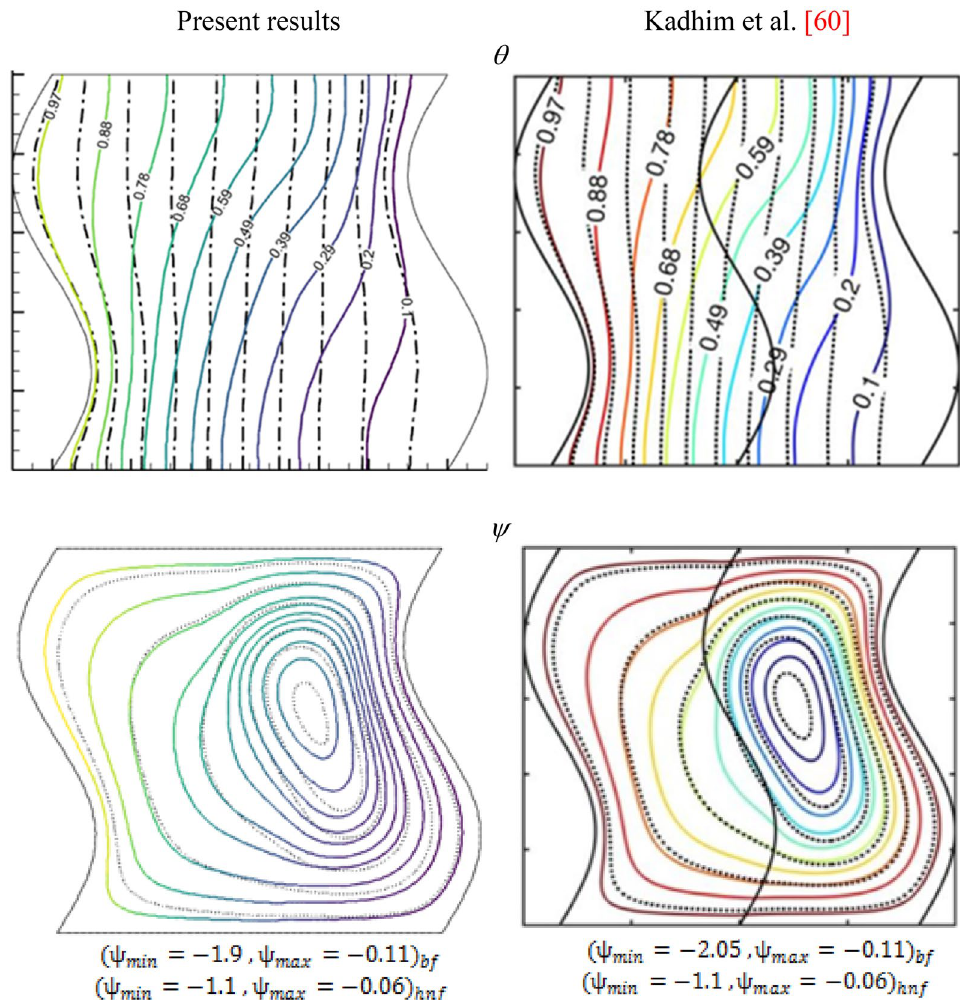
Figure 4. Comparison the streamlines and isotherms of present and Kadhim et al. 58 study, at Ra = 10 5 , and ϕ = 0.1(solid line) ϕ = 0 (dash line).